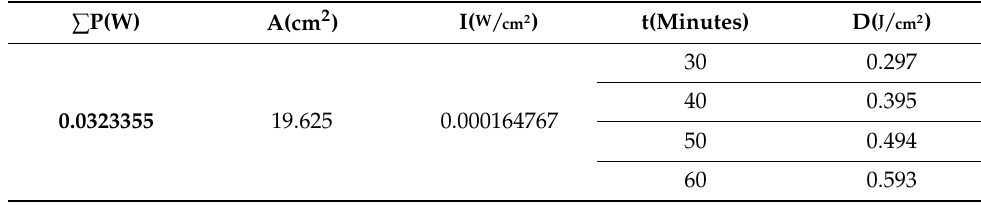
Table 2. Intensity and Energy Dose Values of Infrared LEDs.